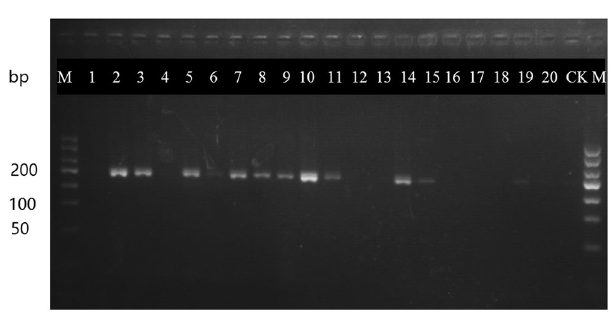
Figure 2. Specific primer pair DZF1/R1 amplification from extractives. Note: Except for the lanes marked M (marker) and CK (negative control), the remaining 20 lanes contain PCR products from 1 to 20 were Lonicerae japonicae Flos extracts amplified by DZF1/R1. All the order is the same as Table 1, and 2, 3, 5, 7–11, 14, 15 were represented the result that Eucommiae Folium can be detected through specific primer pair